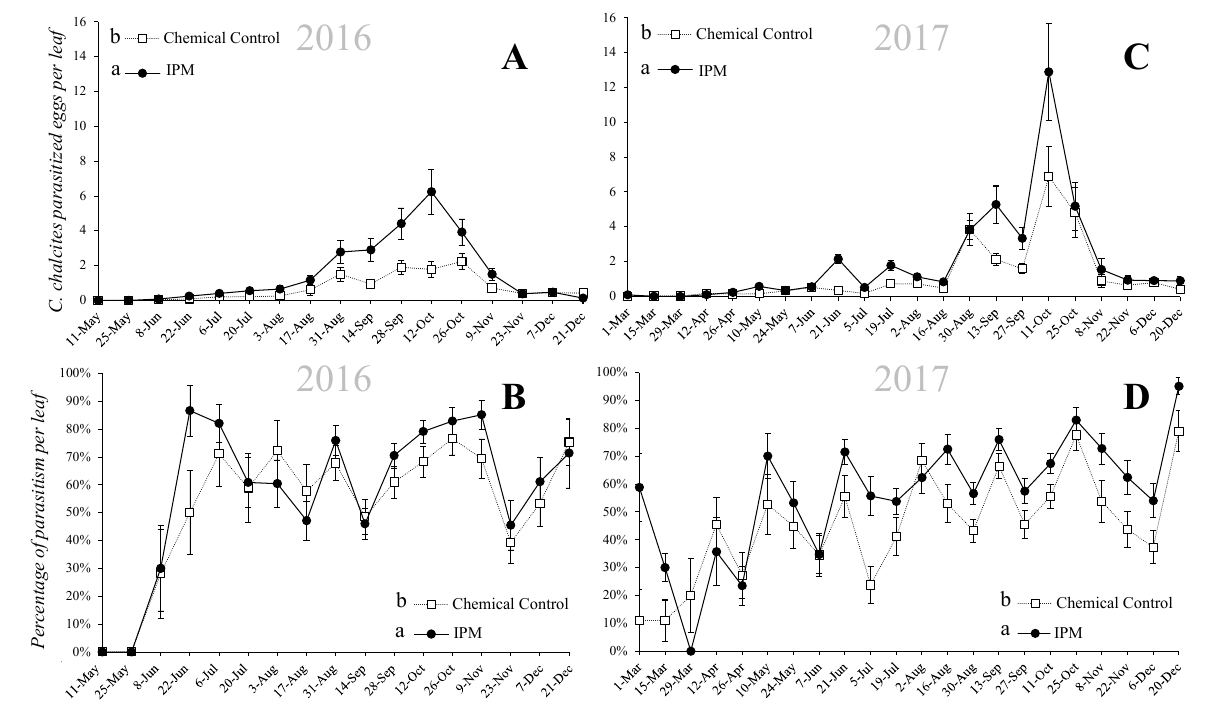
Figure 2. Number (mean ± SE) of parasitized C. chalcites eggs per leaf in 2016 ( A ) and 2017 ( C ) and incidence of parasitized (percentage ± SE) C. chalcites eggs per leaf in 2016 ( B ) and 2017 ( D ) in each treatment. Legends with different letters were significantly different (GLMM, p < 0.05).